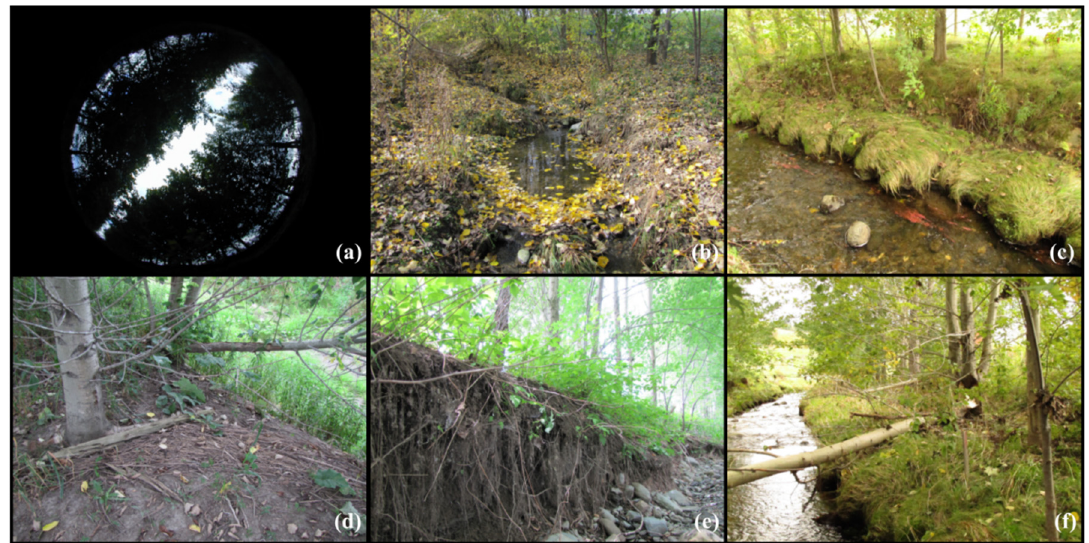
Figure 3. ( a ) Canopy closure shown by a hemispherical photo taken above a headwater farm stream protected by a 6 year ‐ old poplar buffer (Brompton, QC, Canada); ( b ) leaf litter input to stream from